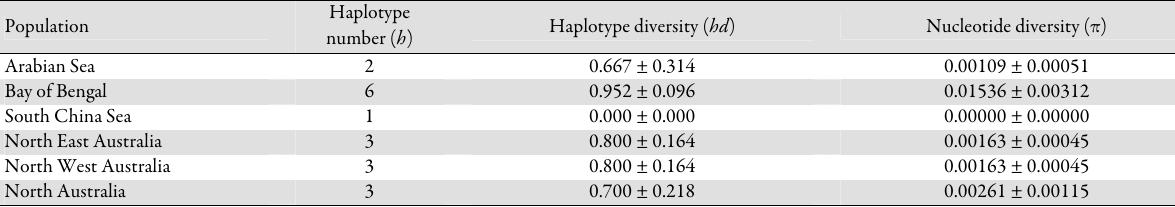
Haplotype Haplotype diversity ( hd ) number ( h )